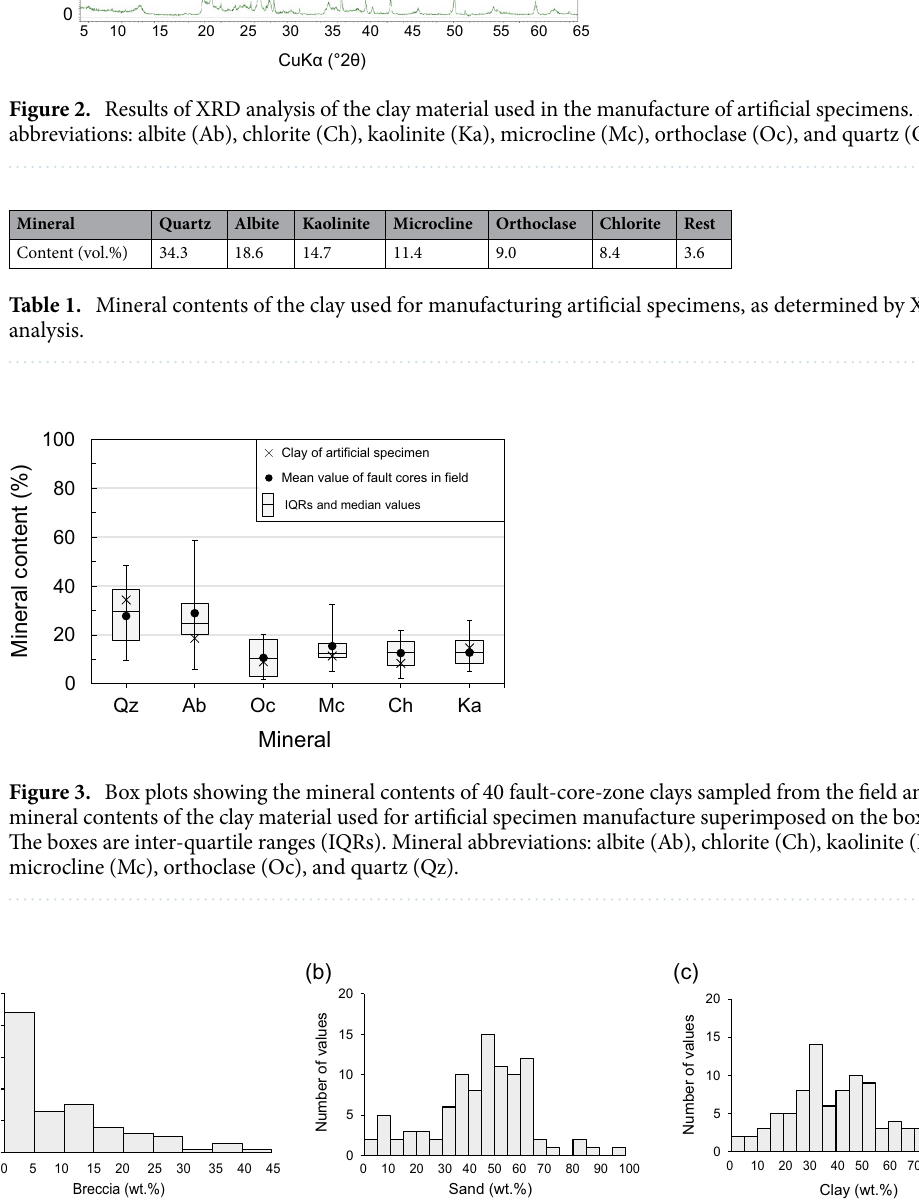
Figure 4. Histograms of ( a ) breccia, ( b ) sand, and ( c ) clay components in 96 natural fault cores obtained from the several fault zones in South Korea. These particle-size data were used to determine the mixing ratios of constituent components in the artificial